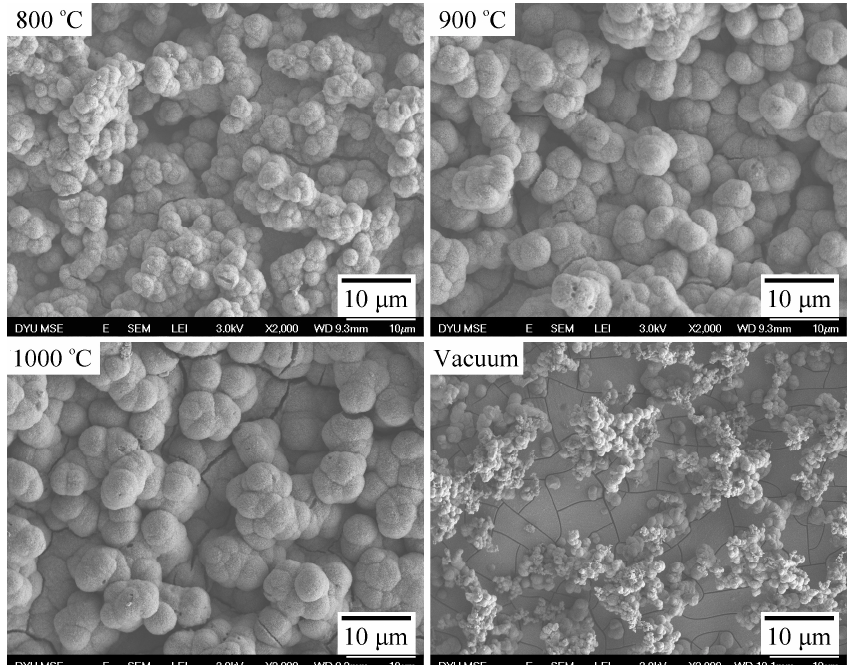
Figure 4. SEM micrographs of the surface morphology of Ti samples sintered at 800, 900, and 1000 °C in air and of a Ti sample sintered in vacuum after immersion in simulated body fluid (SBF) for 21 days.